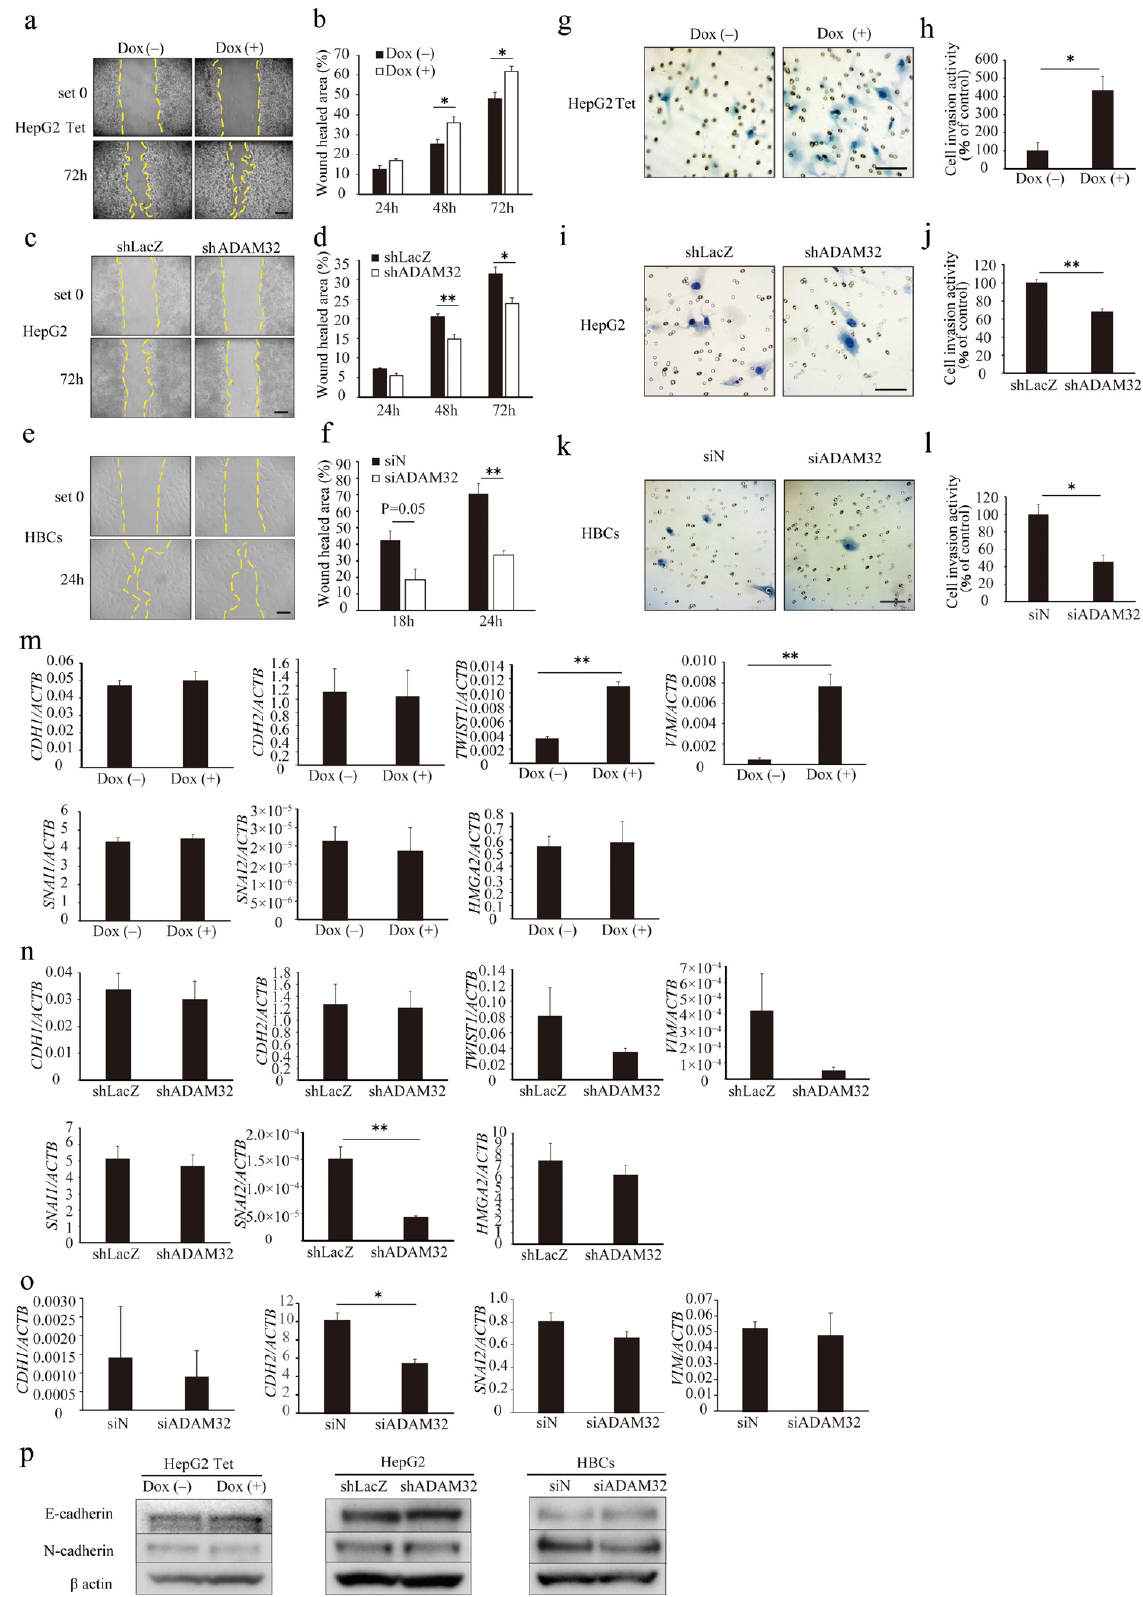
Figure 4. ADAM32 induces cell migration and invasion. Representative images for ( a ) HepG2 Tet, ( c ) HepG2, and ( e ) HBCs transiently transfected with shRNA or siRNA and incubated for 48 h in the wound-healing assays. Calculated proportions of healed areas (%) are shown in bar graphs for ( b ) HepG2 Tet (n = 4), ( d ) HepG2 (n = 4), and ( f ) HBCs (n = 3). Representative images from the cell invasion assay are shown for ( g ) HepG2 Tet, ( i ) HepG2, and ( k ) HBCs transiently transfected with shRNA or siRNA and incubated for 48 h. The calculated ratios (%) of invading cell number to control are shown in bar graphs for ( h ) HepG2 Tet (n = 4), ( j ) HepG2 (n = 3), and ( l ) HBCs (n = 3). Expression levels of EMT-related genes were evaluated with real-time RT-PCR by using total RNA prepared from ( m ) HepG2 Tet with or without Dox for 96 h, ( n ) HepG2, and ( o ) HBCs transiently transfected with shRNA or siRNA and incubated for 48 h. Relative gene expression levels were calculated as the ratio to ACTB levels (n = 3). ( p ) Expression levels of EMT-related proteins were evaluated with immunoblotting using protein prepared from HepG2 Tet, with or without Dox for 96 h, and HepG2 and HBCs transiently transfected with shRNA or siRNA and incubated for 48 h. Scale bar = 200 μ m. ( b , d , f , h , j , l , m , n , o ) Values are summarized by mean and SE. * p < 0.05; ** p < 0.01; Und, undetermined. All the whole immunoblotting figures can be found in Figure S11.